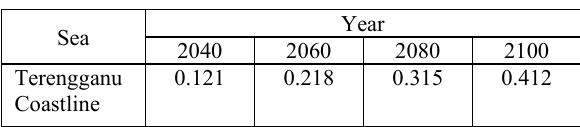
Figure 6. The sea level trend derived from altimetry data at Cendering tide gauge station